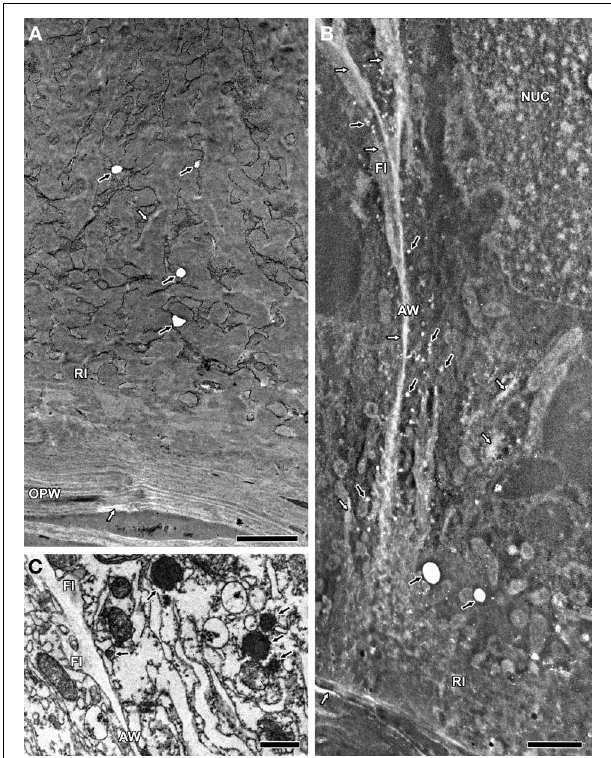
FIGURE 2 | TEM images of ultrathin MBETC sections at 10 DAP, after H 2 O 2 treatment without contrast (A and B) and control sections at 6 DAP without treatment and contrast (C). (A) After a 15-min H 2 O 2 treatment, some vesicles lacked electron density ( black arrows ), whereas reticulate ingrowths and the OPW show regions with less electron density ( white arrows ). (B) After a 60-min H 2 O 2 treatment, many vesicles lost their electron density ( black arrows ), whereas reticulate and flange ingrowths, the OPW and anticlinal walls reveal large regions with less electron density ( white arrows ). (C) Control sections with electron-dense vesicles ( black arrows ), whereas the walls and flange ingrowths have a weak electron density. AW , anticlinal wall; FI , flange ingrowth; NUC , nucleus; OPW , outer periclinal wall; RI , reticulate ingrowth. Scale bars : (A,B) = 2 µ m, (C) = 1 µ m.